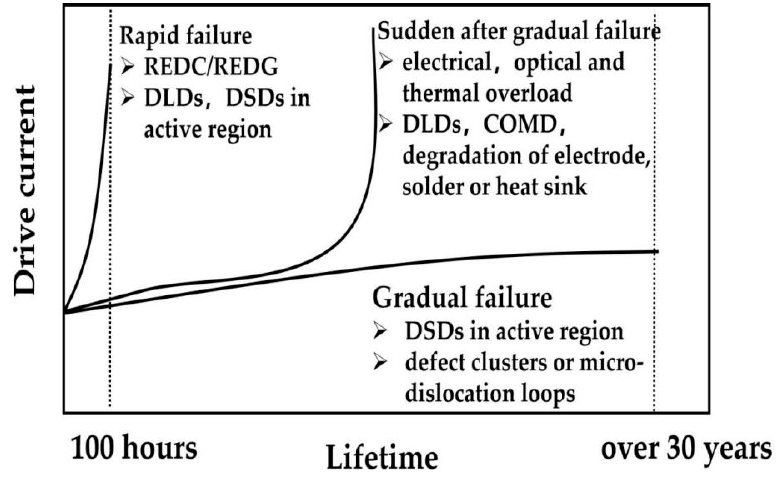
Figure 1. Failure mode of the laser diode at constant output power.